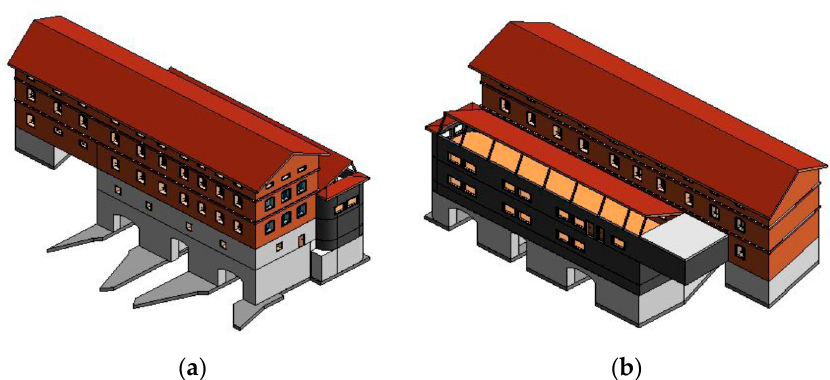
Figure 6. BIM model of the body of the factory: second phase, current condition. ( a ): Front view; ( b ) Rear view.